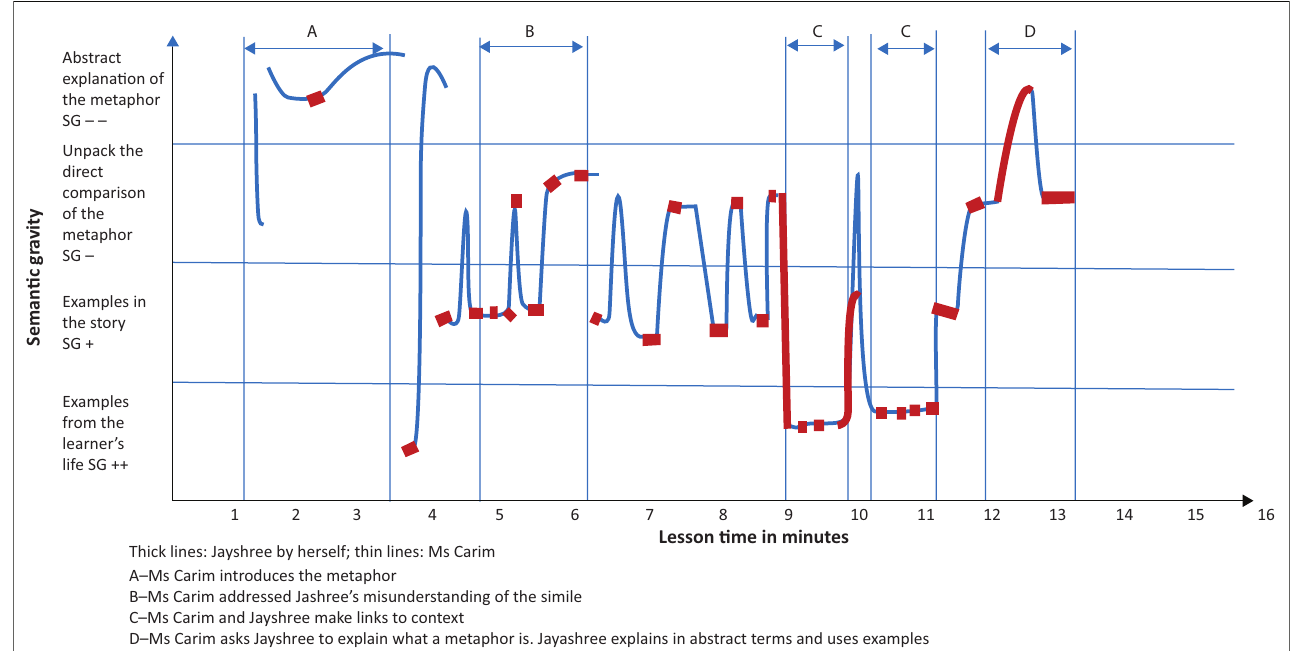
FIGURE 2: Semantic profile for Jayshree’s